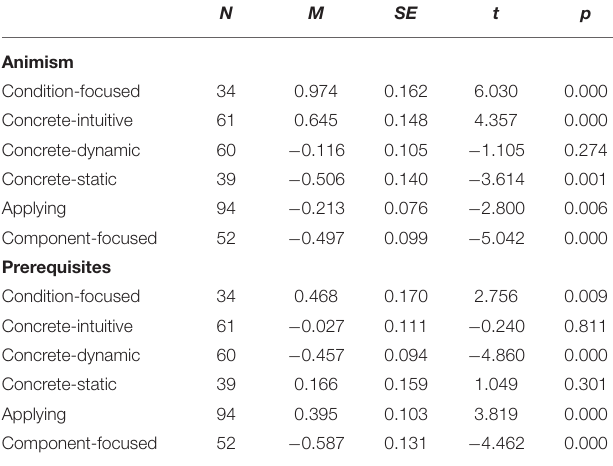
Table 4 for profile sizes and the distribution of gender and study program for each ontological